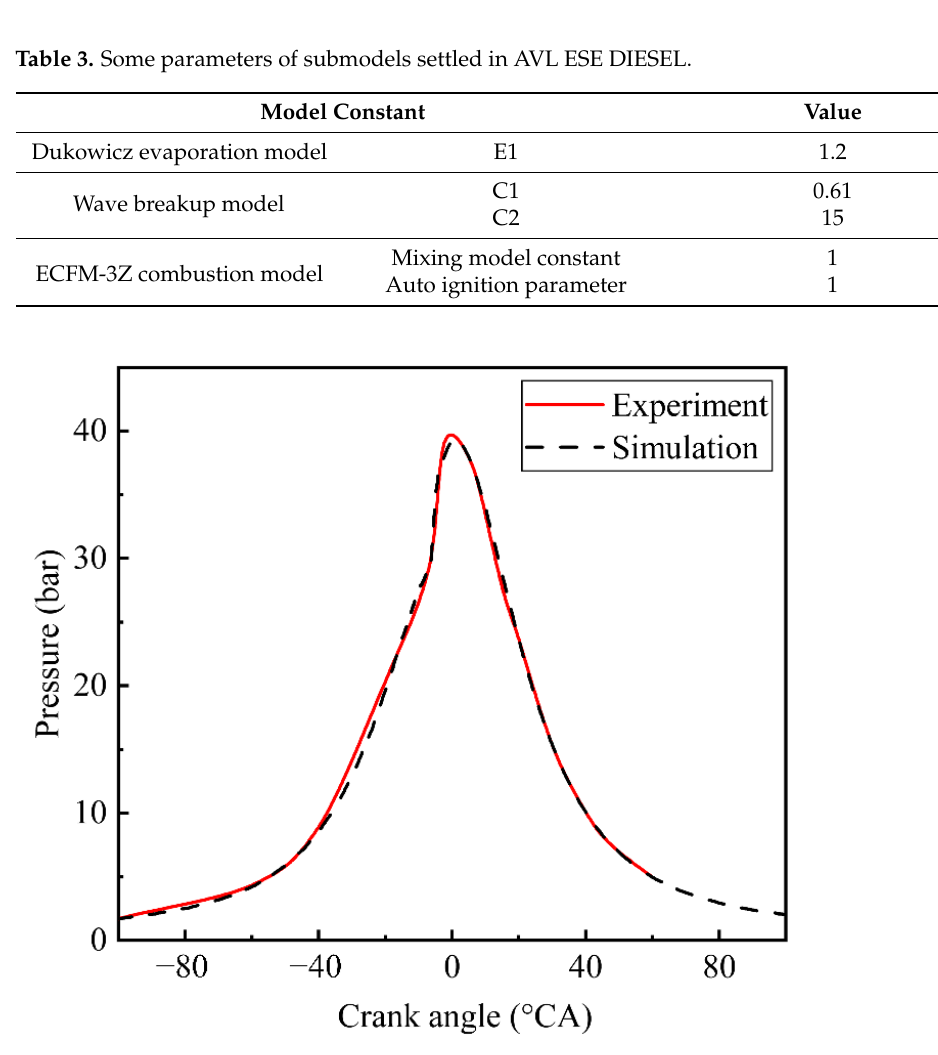
Figure 5. The comparison of the simulated in-cylinder pressure based on the crank angle when idle with experiment data. Table 4. The comparison of the BSNOx and BSCO emissions between simulation and experiment. Engine